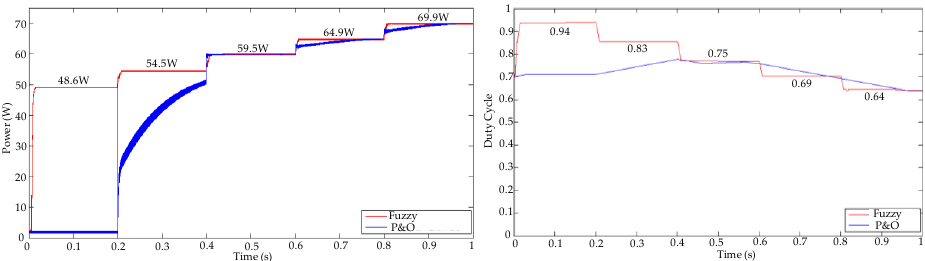
Figure 20. ( a ) Output power of the PV module for decreases in temperature; ( b ) Duty cycle. Case 4: variations in solar irradiance and temperature Finally, the performance of the system was evaluated for sudden changes in temperature and solar irradiance in different time values between 0 and 1 s, as seen in Figure 21.